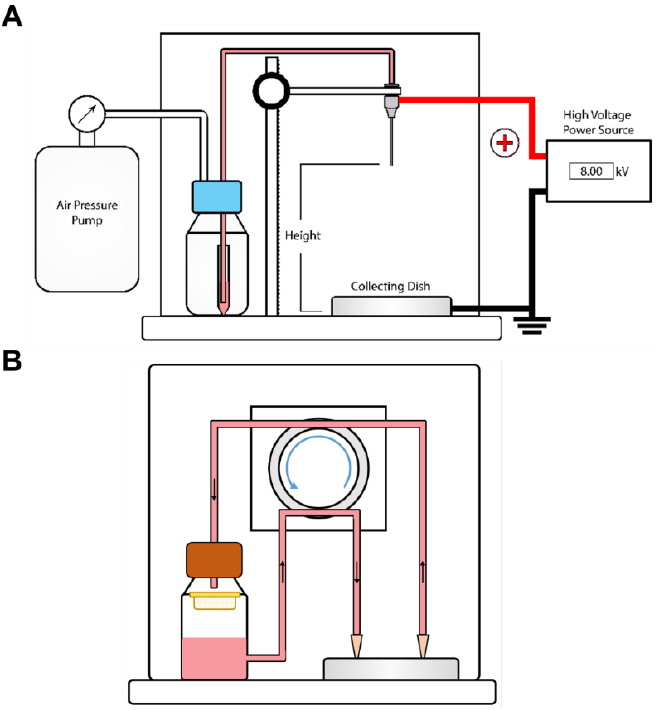
Figure 4. Schematic of Encapsulator and RaCCS. ( A ) An air pump is used with constant pressure to pressurize the vessel containing the alginate cell suspension, which provides force to drive it towards the needle. Spherical droplets fall in the electric field into the collecting dish where they are crosslinked. ( B ) The RaCCS consists of a peristaltic pump that drives crosslinking buffer into the dish through an inlet tube and the capsules are collected through an outlet tube onto a filter (yellow) and washed.